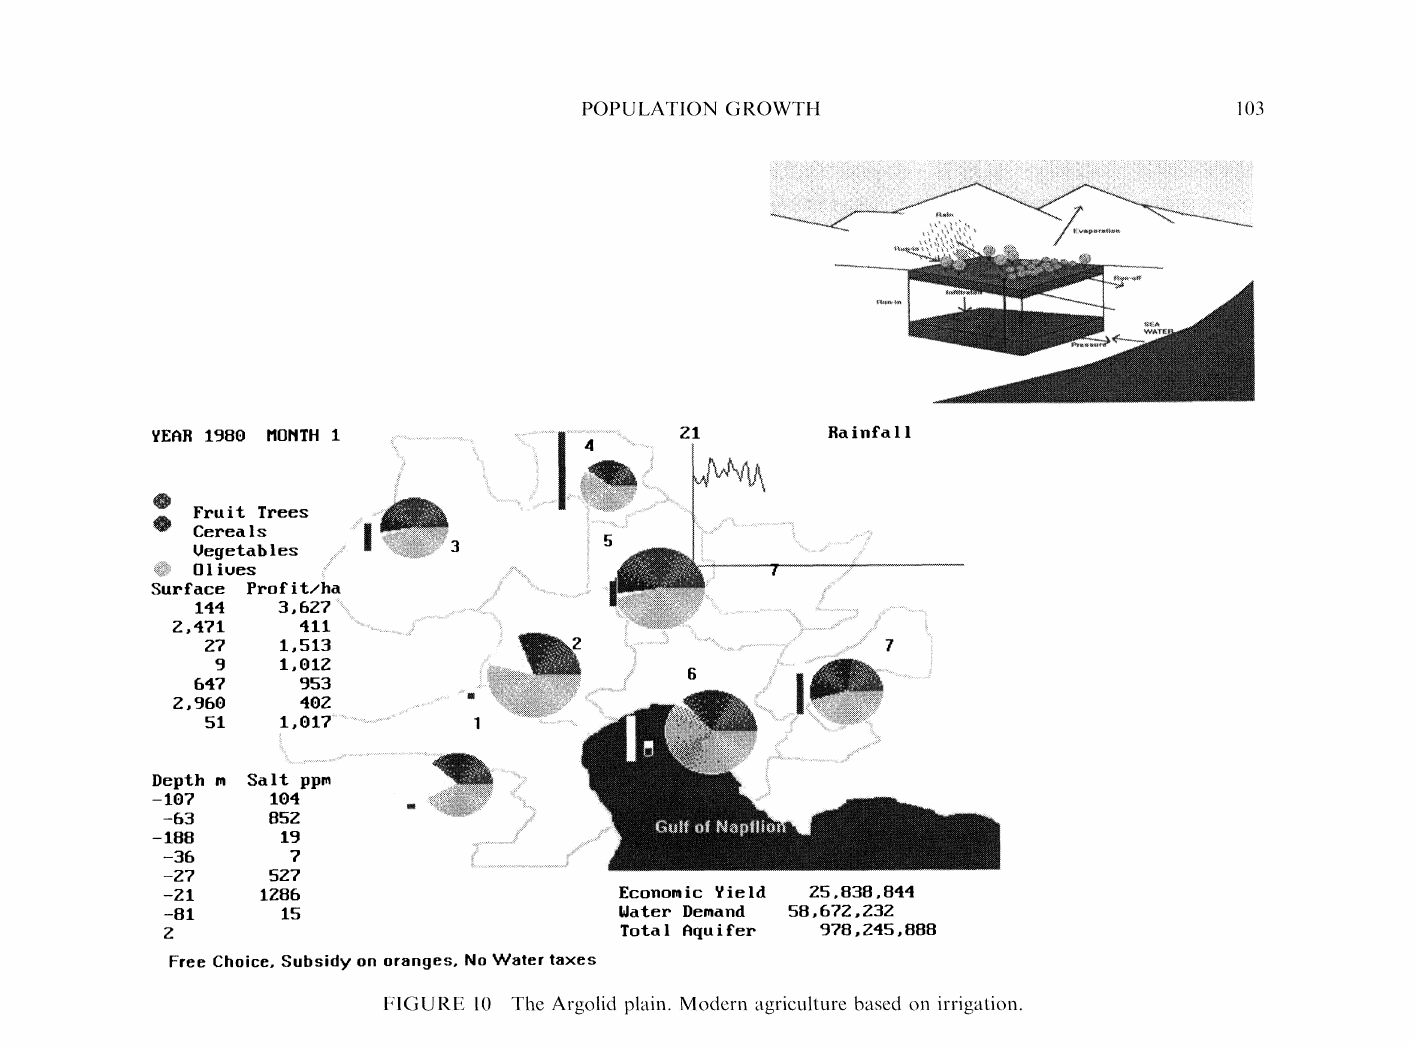
FIGURE 10 The Argolid plain. Modern agriculture based on